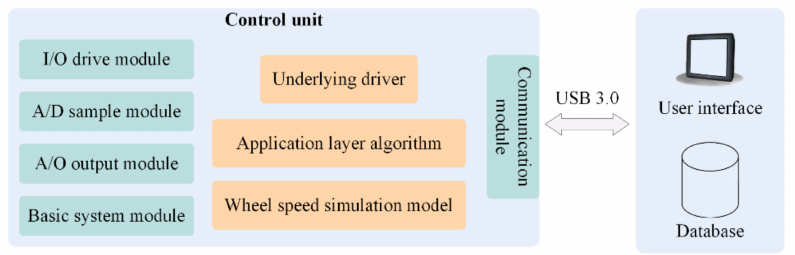
Figure 3. Framework of an EOL test system for a control